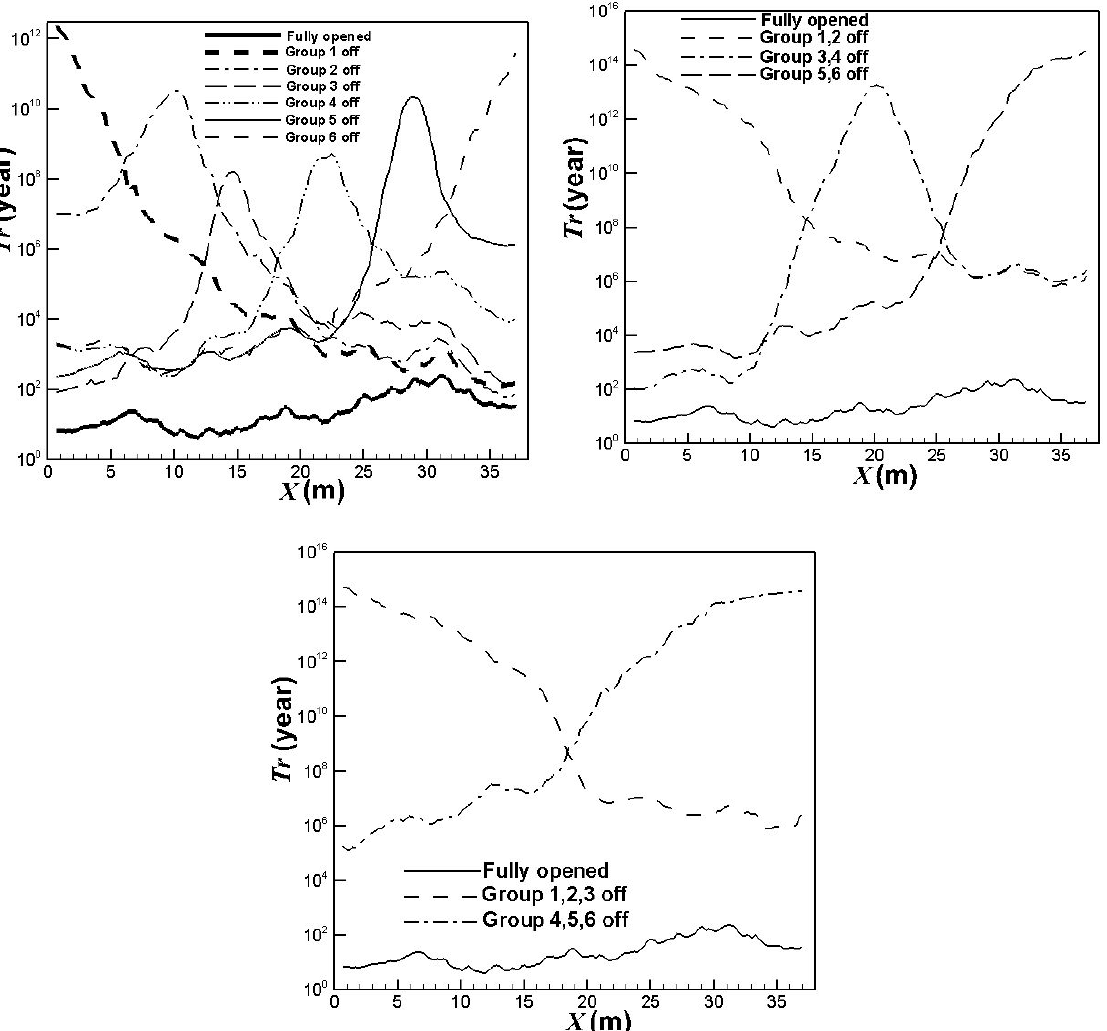
Figure 10. Lifetimes for the catalyst tubes of different burners on/off combinations.